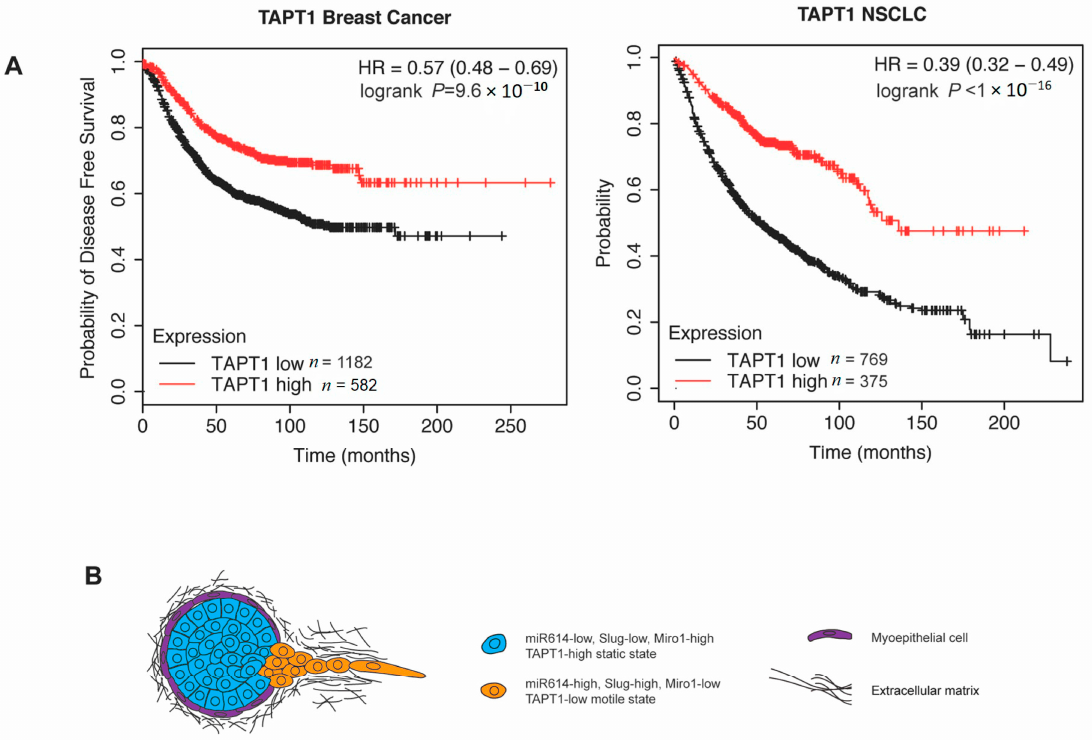
Figure 5. Reduced TAPT1 expression correlates with worse outcome in breast cancer and non-small cell lung cancer (NSCLC) patients. ( A ) Kaplan–Meier curves showing the disease-free survival of breast cancer patients and NSCLC patients classified as “TAPT1 high” and “TAPT1 low” based on TAPT1 mRNA expression. Survival differences were compared by log-rank test. ( B ) Model proposing how miR614 promotes a more motile EMT state by inhibiting Miro1 and TAPT1